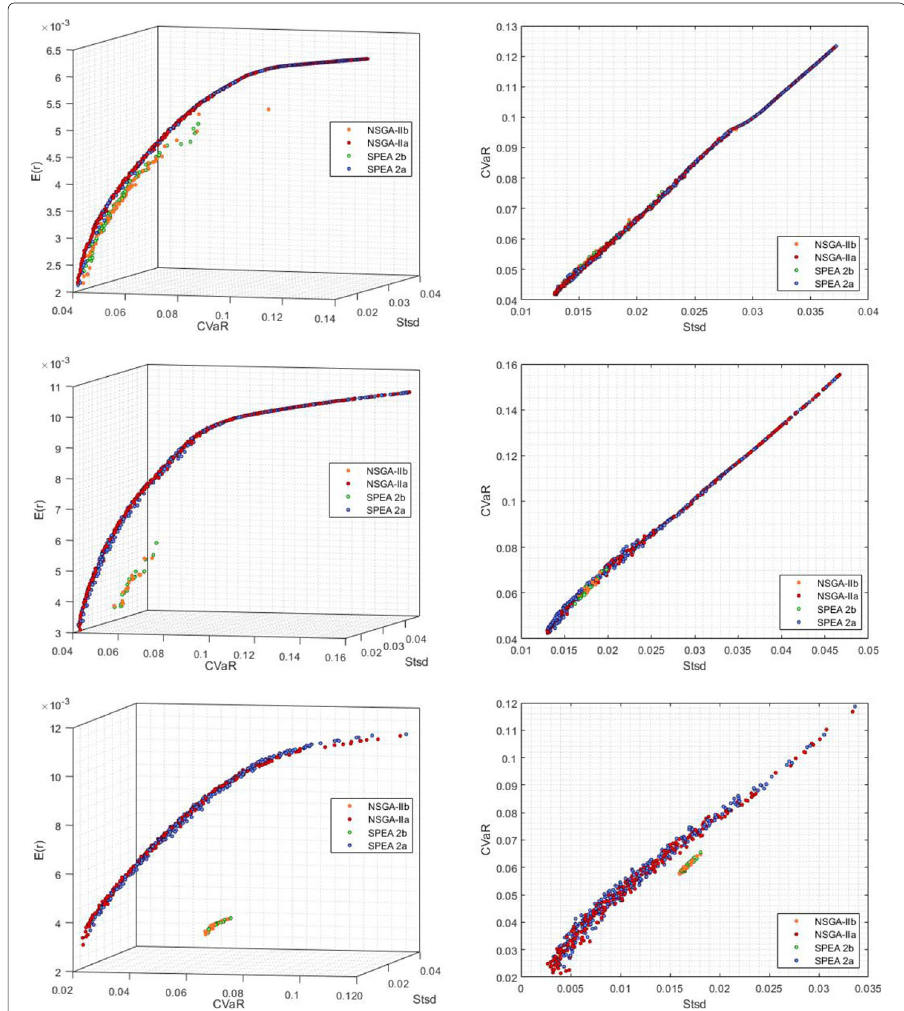
Fig. 2 Approximated Pareto fronts for the Mean-Stsd-CVaR portfolio optimization problem (on the left) and their projections onto the Stsd-CVaR plane (on the right) corresponding to the simulations with the highest HV values obtained by NSGA-IIb, NSGA-IIa, SPEA 2b and SPEA 2a for the datasets DowJones (charts at the top), NASDAQ100 (charts in the middle) and NASDAQComposite (charts